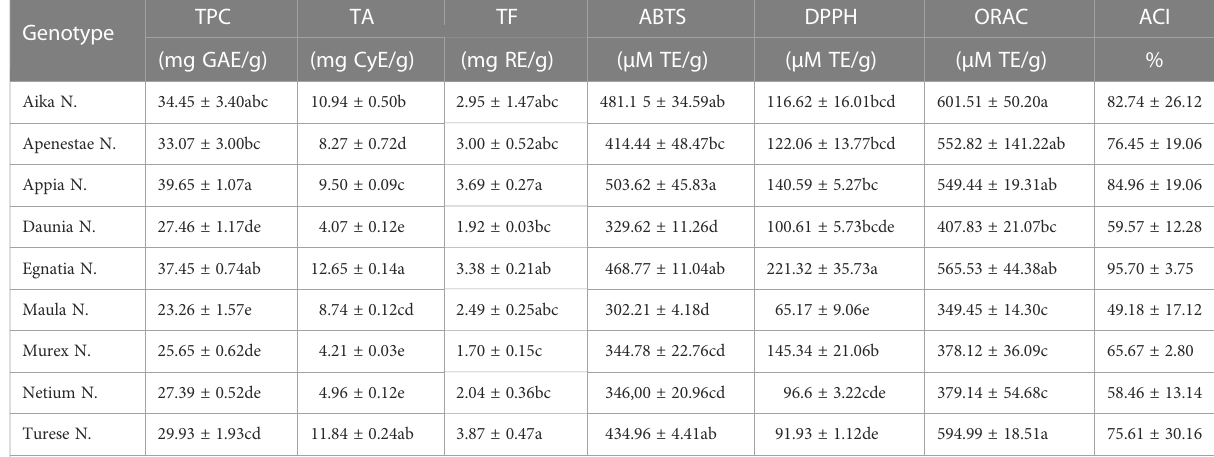
TABLE 1 Total phenolic content (TPC), total anthocyanins (TA), total fl avonoids (TF), antioxidant activity (ABTS, DPPH, and ORAC assays) and Antioxidant Composite Index (ACI) of nine new Apulian